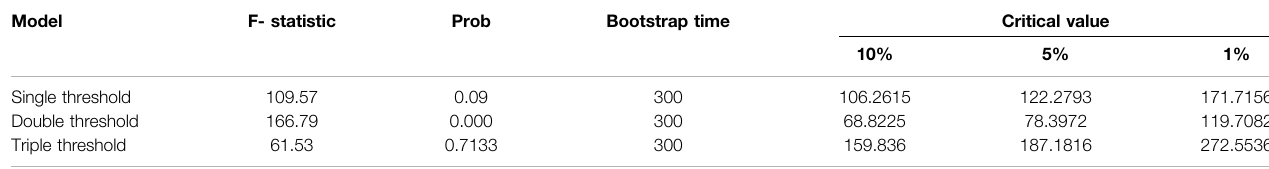
TABLE 4 | Threshold estimation and test results. Model